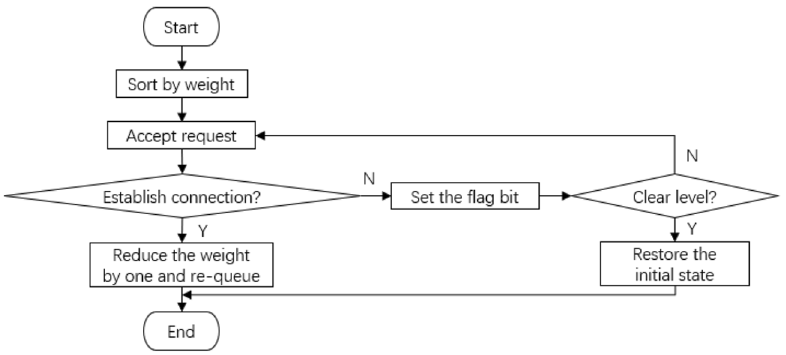
Fig. 12 The processing flow- chart of the weighted